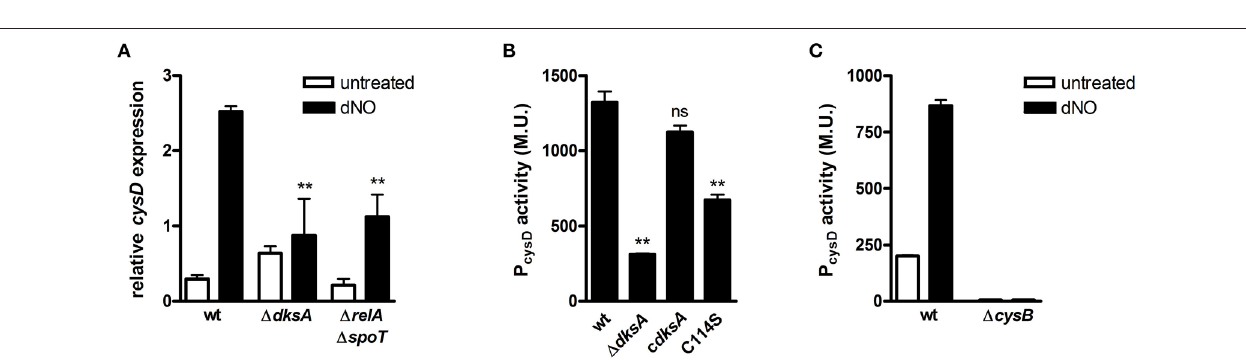
FIGURE 5 | Cellular requirements for DksA-dependent transcriptional activation of cysteine biosynthesis in response to • NO. (A) cysD expression in wild-type (wt), 1 dksA , and ppGpp-null ( 1 relA / 1 spoT ) Salmonella 30 min after treatment ± 5mM dNO as measured by qPCR. Gene expression, normalized to the house-keeping gene rpoD , is expressed as fold change relative to untreated controls. Data are the mean ± SEM, n = 3; ** p < 0.01 and ns (non-significant) compared to dNO-treated wild-type Salmonella . (B) cysD promoter activity in wild-type (wt), 1 dksA , and dksA -null Salmonella complemented with the native (c dksA ) or C114S dksA allele following treatment ± 5mM dNO for 2 h. Data are expressed as Miller Units (M.U.) and are the mean ± SEM, n = 3; ** p < 0.01 and ns (non-significant) compared to wild-type Salmonella . (C) cysD promoter activity in wild-type (wt) and 1 cysB Salmonella 2 h after treatment ± 5mM dNO. Data, expressed as M.U., are the mean ± SEM, n =